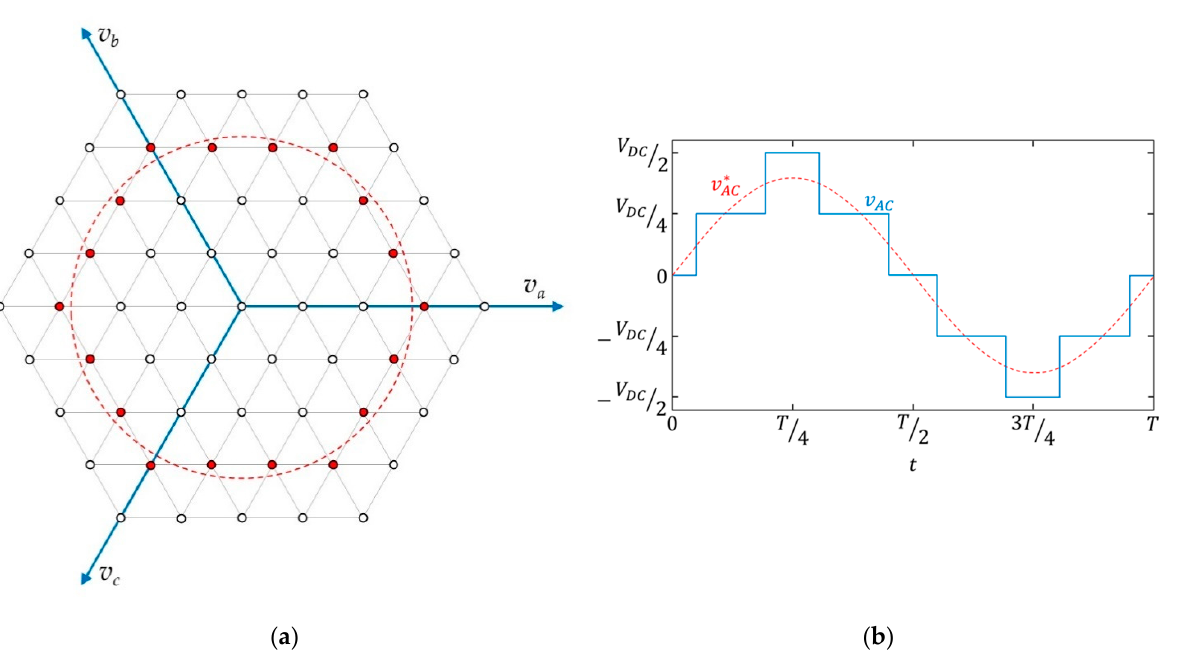
Figure 4. Five-level three-phase converter: ( a ) space vector control; ( b ) nearest-level control in one converter leg (modulation index m = 0.8).